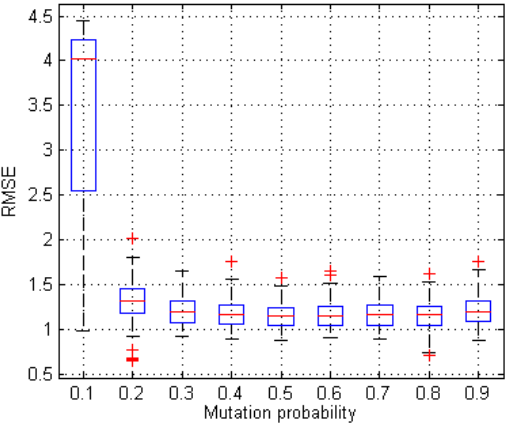
Figure 4. Box plots of the RMSE with different mutation probability.